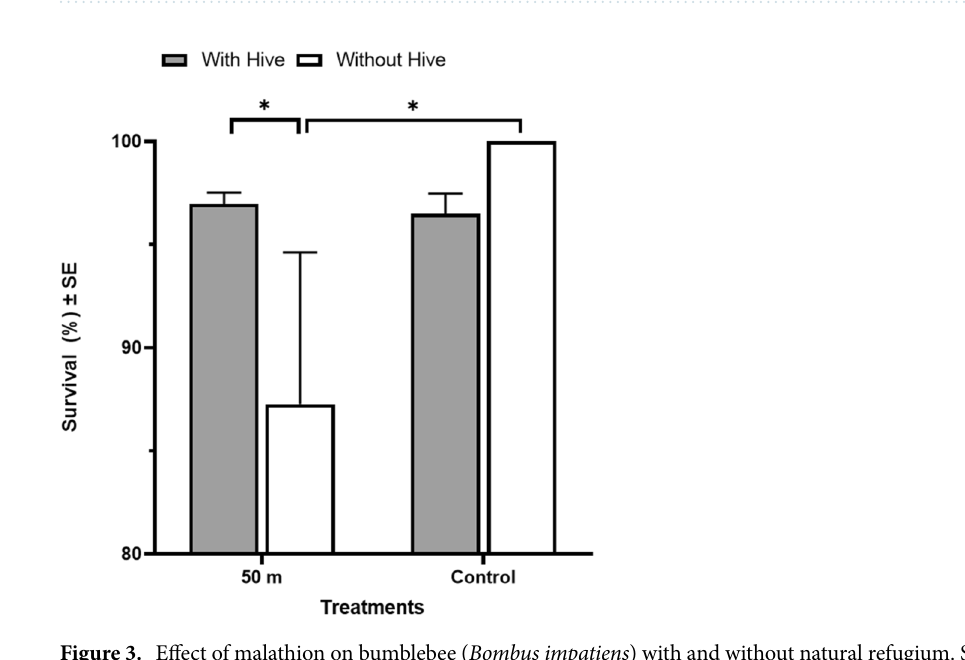
Figure 3. Effect of malathion on bumblebee ( Bombus impatiens ) with and without natural refugium. Survival rate of bumblebees (N = 671 total) with and without refugia (hive) at 50 m distance from truck-mounted sprayer applying malathion ULV spray at the maximum label rate. Asterisks indicate significant differences between groups ( p < 0.05), using GLM with likelihood ratio